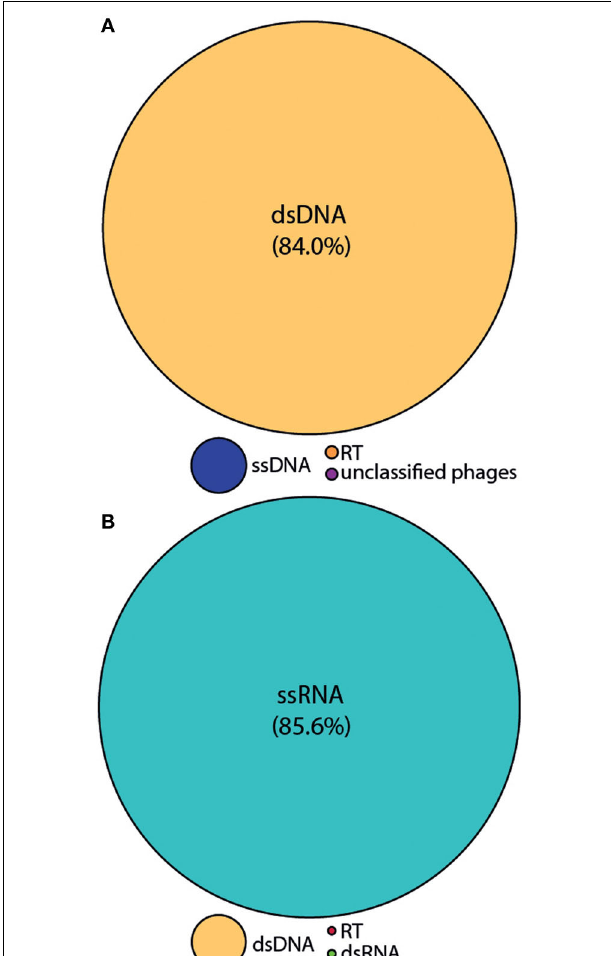
FIGURE 5 | Annotation of the Acropora tenuis (A) DNA and (B) RNA virome metagenomic sequences with a match to viral sequences for the MECH method following storage in liquid nitrogen and amplified by RP-SISPA. Best matches to the major viral groups were